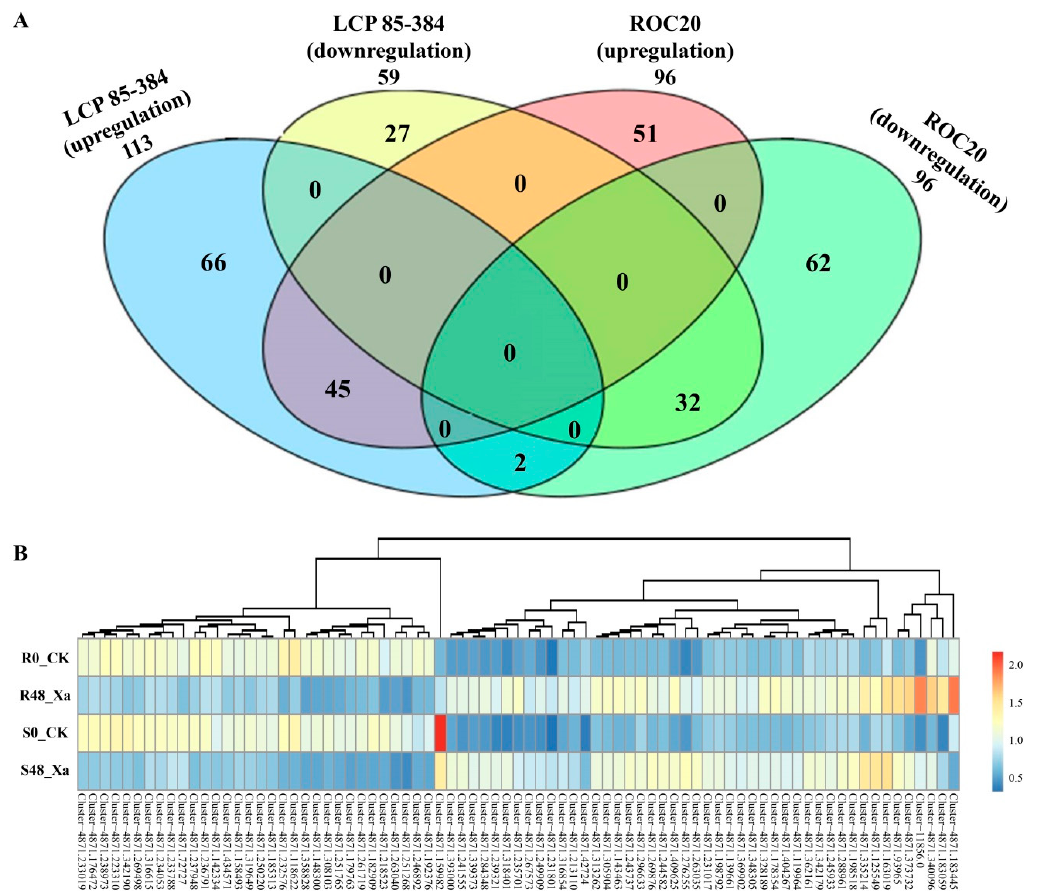
Figure 1. ( A ) Venn diagram of the 285 differentially expressed proteins (DEPs) and ( B ) heat map of expression changes (average of three biological replicates) of 79 common DEGs identified in two sugarcane cultivars inoculated with Xanthomonas albilineans . LC P85–384 is resistant to leaf scald and ROC20 is susceptible to the disease. The number of statistically significant DEPs was based on a p value ≤ 0.05 and a fold change of protein expression ≥ 1.5 (upregulation) or ≤ 0.67 (downregulation). The total numbers of DEPs for each treatment are shown outside the circles and the numbers of DEPs exclusively expressed in one treatment are shown in each circle. The overlapping section of two-four circles represents the common DEPs between all treatments: upregulated DEPs in R48_Xa vs. R0_CK (in blue), downregulated DEPs in R48_Xa vs. R0_CK (in yellow), upregulated DEPs in S48_Xa vs. S0_CK (in pink), downregulated DEPs in S48_Xa vs. S0_CK (in green). R0_CK = cultivar